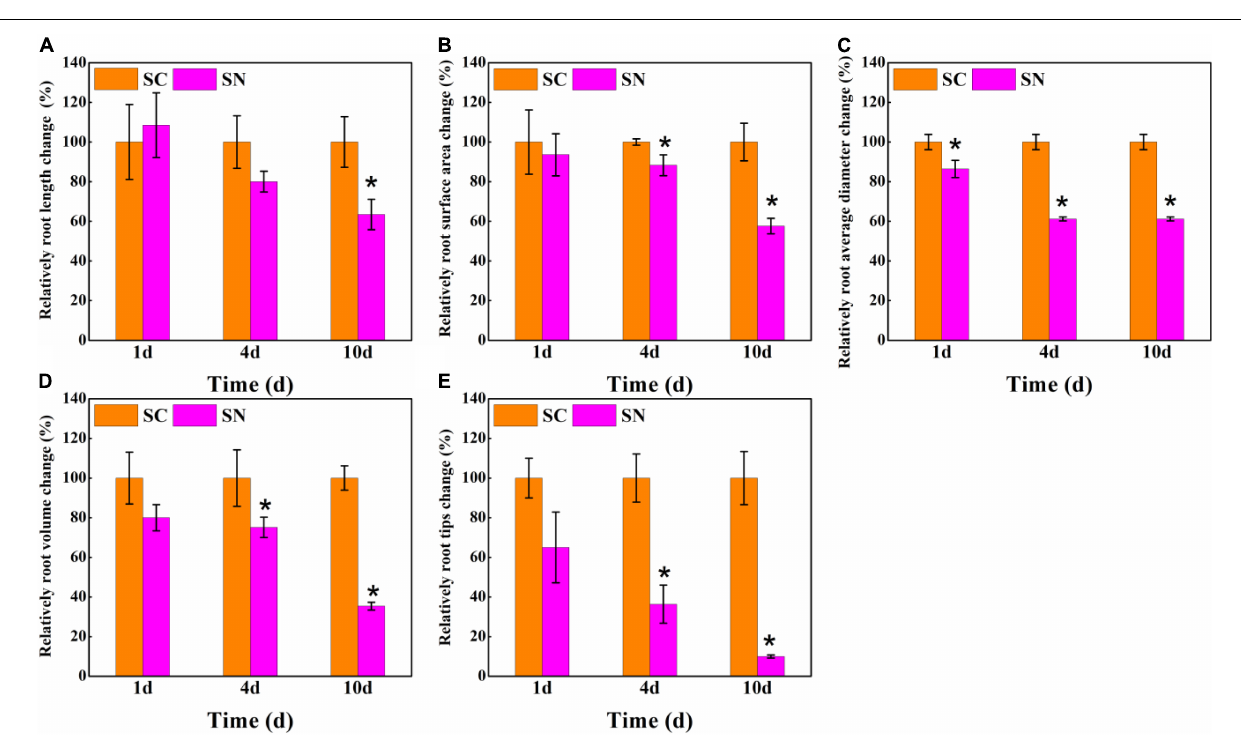
FIGURE 2 | Effects of high-nitrate stress on relative root architecture change of tomato after 1-day, 4-day, and 10-day treatment. (A) Total root length; (B) Root surface area; (C) Root diameter; (D) Root volume; (E) Root tips. SC, control; SN, high-nitrate stress treatment. Asterisks indicate significant differences between SC and SN treatment at the P < 0.05